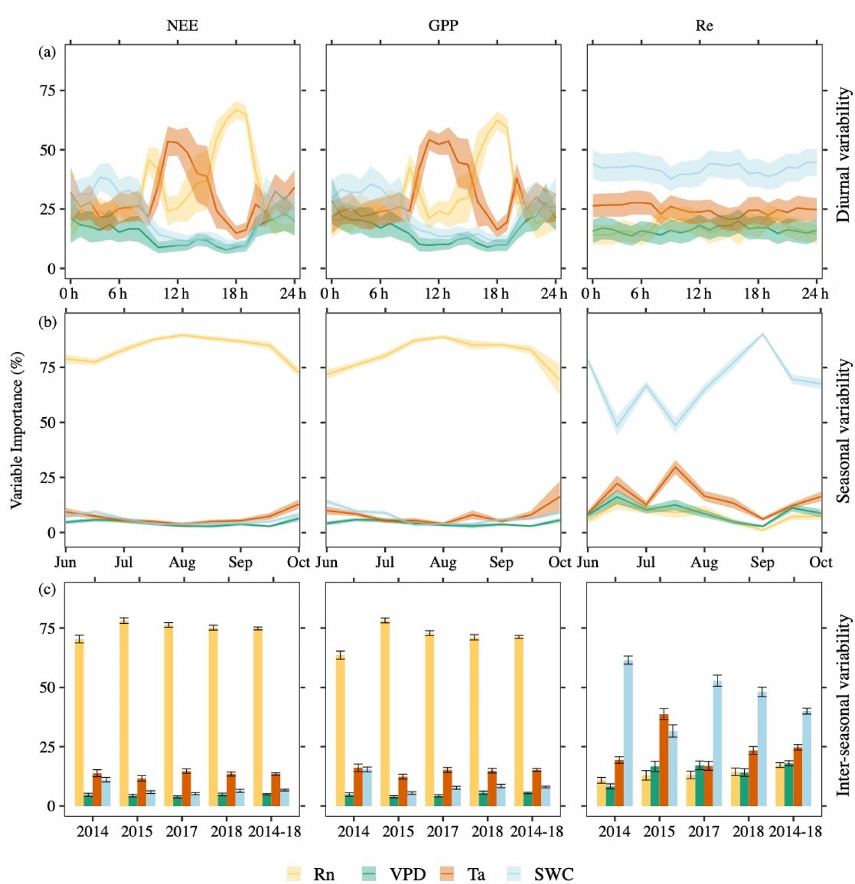
Figure 5. Contribution to diurnal and seasonal variation of NEE, GPP, and Re from different environmental drivers (Rn (yellow), Ta (orange), SWC (blue), and VPD (green)). Solid lines with shades (diurnal and seasonal variability) and bars with error bars (inter-seasonal variability) both illustrate the average ± standard deviation of the importance across 1000 decision trees. Inter-seasonal variability refers to the variability of the integrated growing season of 2014, 2015, 2017, and